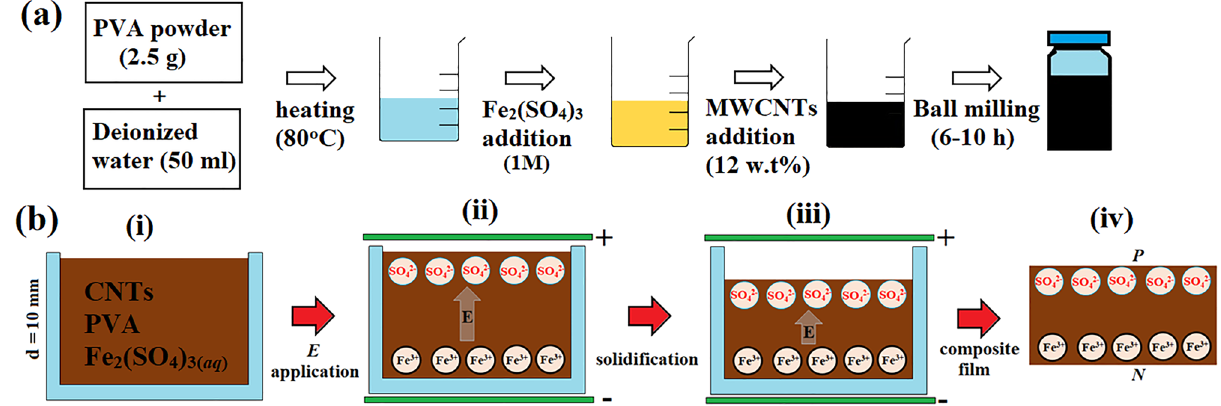
Figure 1. Preparation of PVA/Fe 2 (SO 4 ) 3 (aq) /CNTs ( a ) and E treatment of suspension until solidification ( b